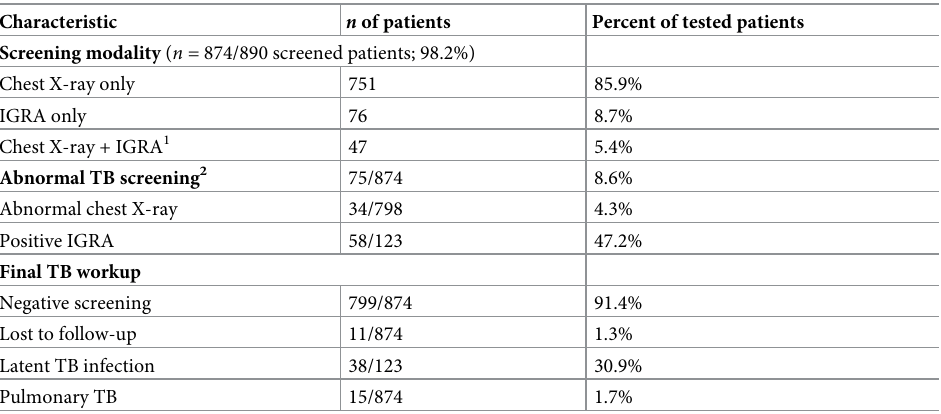
Table 3. TB screening. Characteristic n of